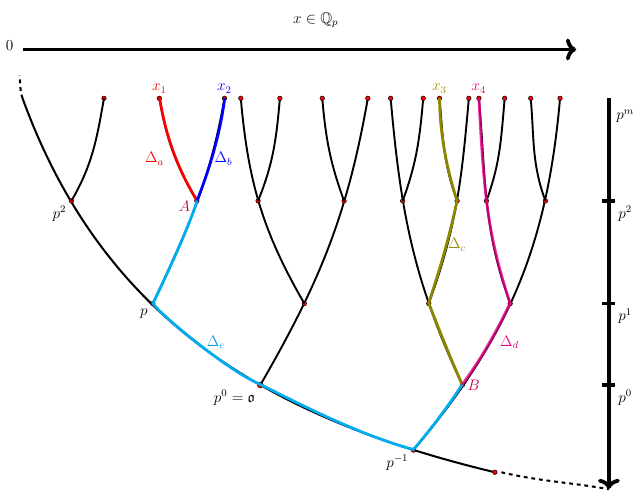
Figure 9. Computation of the 4-point function from the tensor